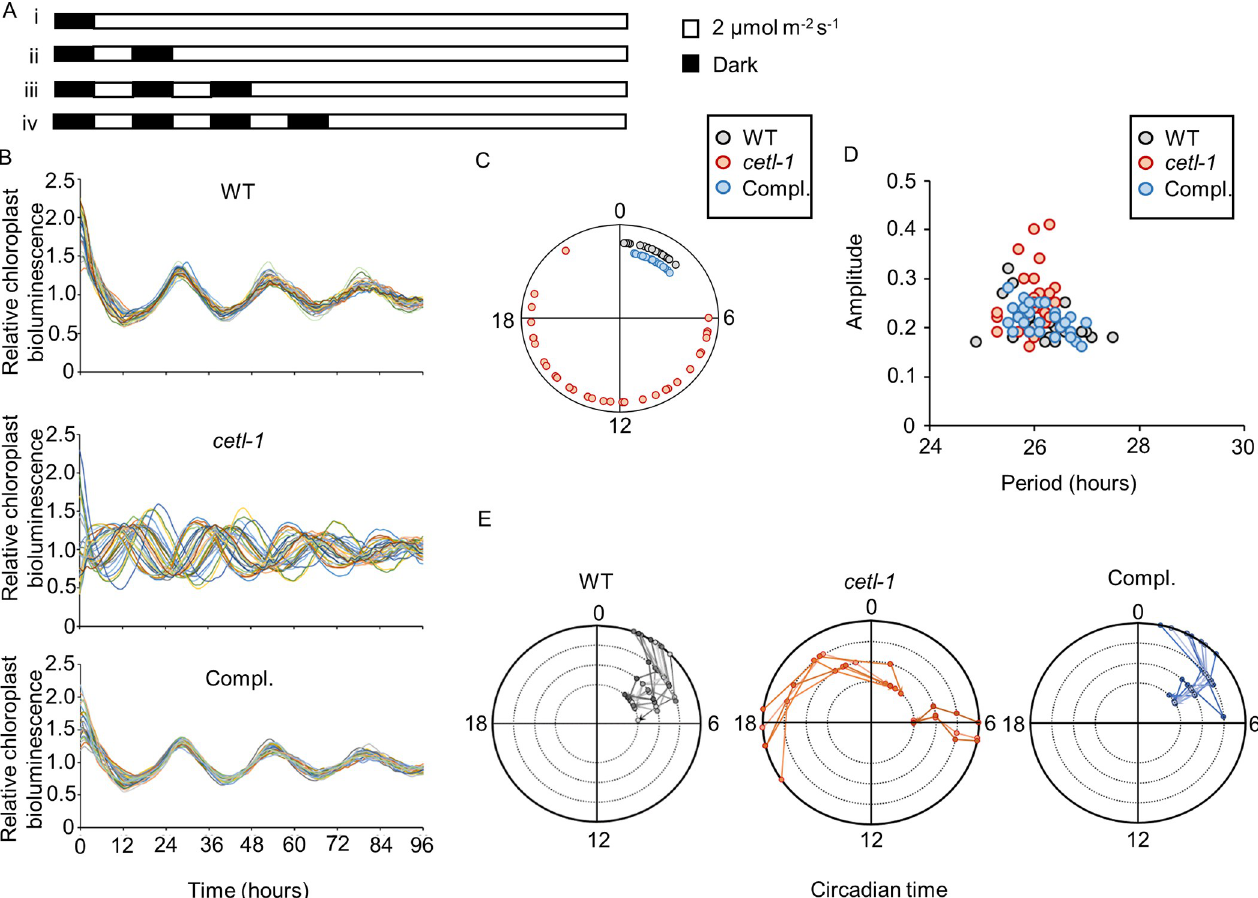
Fig 7. Phase distribution in LL in single colony protocol in cetl-1 . The CBR (mt + ) (wild type [WT]), mutant progeny ( cetl-1 ), and complement progeny (Compl.) from the cross mentioned in Fig 6 were used to observe the chloroplast bioluminescence rhythm. Spot cultures were prepared using the single colony protocol depicted in S13 Fig . A . Light regimes ( i - iv ) used for the experiment. Colonies were exposed to progressive LD (12 hours:12 hours) cycle before release into LL conditions ( ii-iv ). B . Chloroplast bioluminescence rhythms of the WT, cetl-1 , and Compl. as observed after light schedule i . Cultures were maintained in 12 hours of darkness before release into LL conditions. Data of 28 biological replicates each, of WT and Compl., and 32 biological replicates of cetl-1 from a single trial are shown. C. Phase diagram showing the circadian phases of cetl-1 , WT and Compl. rhythms shown in B. D Plot of period and amplitude of the bioluminescence rhythms shown in B. E. Peak phases of the quadruplicate spots of biological replicates after each of the four light schedules. The results after light schedules i - iv are plotted from the outermost ring to the innermost ring, respectively. Quadruplicate spots from the same independent culture are connected by a line. Data are shown only for cases where the rhythms were detected for all four spots in an independent culture, and correspond to results of a single trial.